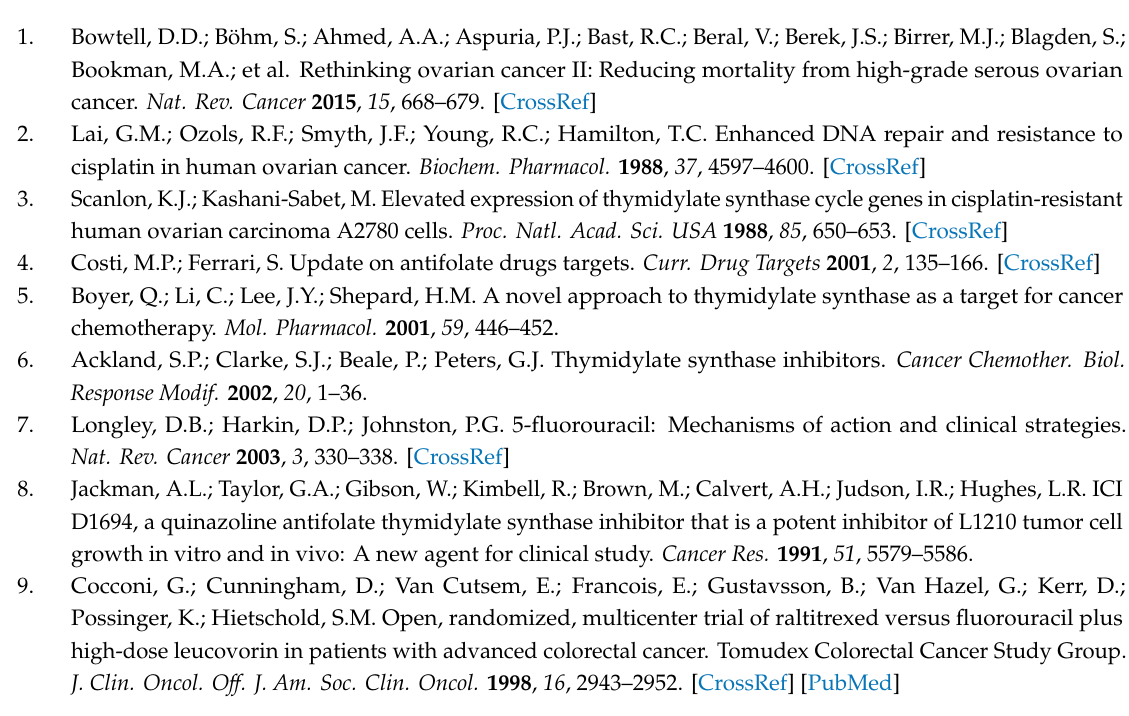
s1. Table S1. IC50 values ( µ M or nM) for selected compounds obtained after 72 h treatment of 2008, C13*, A2780, A2780 / CP, and IGROV1 human ovarian cancer cell lines. Table S2. The e ff ect of 72h-exposure to [DGln4]LR and 5-FU alone and in combination on the cell cycle phase distribution of 2008 and C13* cell lines by cytofluorimetric analysis. Table S3. The e ff ect of 48h- and 72h-exposure to [DGln4]LR and cDDP alone and in combination on the cell cycle phase distribution of 2008 and C13* cell lines by cytofluorimetric analysis. Figure S1. Cell cycle-related analysis of the 2008 cells after treatment with the indicated compounds. Figure S2. Cell cycle-related analysis of the C13* cells after treatment with the indicated compounds. Figure S3. The e ff ect of [DGln4]LR and cDDP alone and in combination on the cell cycle phase distribution of 2008 and C13* cells by cytofluorimetric analysis of the DNA content by PI